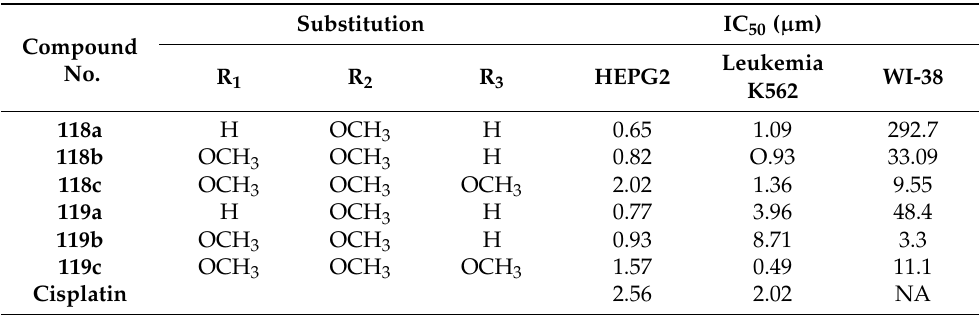
Table 100. In vitro cytotoxic activities of coumarin containing chalcone hybrid compounds [ 118 ( a – c ), 119 ( a – c )].